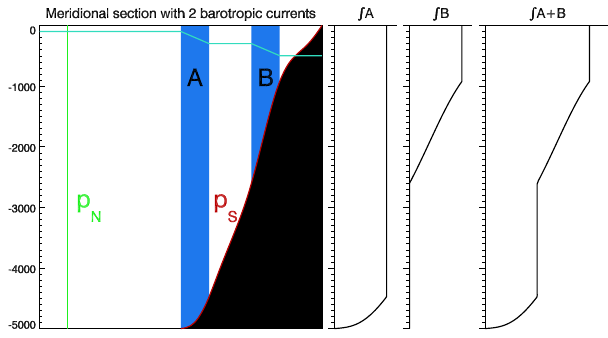
Fig. 1. Schematic showing how two uniform, depth-independent eastward flows (shown as blue-shaded regions A and B ) produce a surface-intensified flow when integrated meridionally across the currents. The left-hand panel represents a meridional section, with Antarctica (black) on the right, and the three right-hand panels show the meridional integrals of currents A , B , and A + B as a function of depth. Cyan illustrates how pressure varies on any horizontal sur- face, and the green and red lines show where pressures p N and p S are